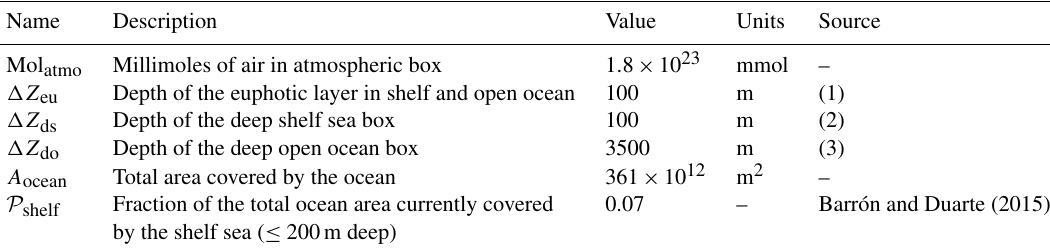
Table 2. Parameters set that describes geometry of the box